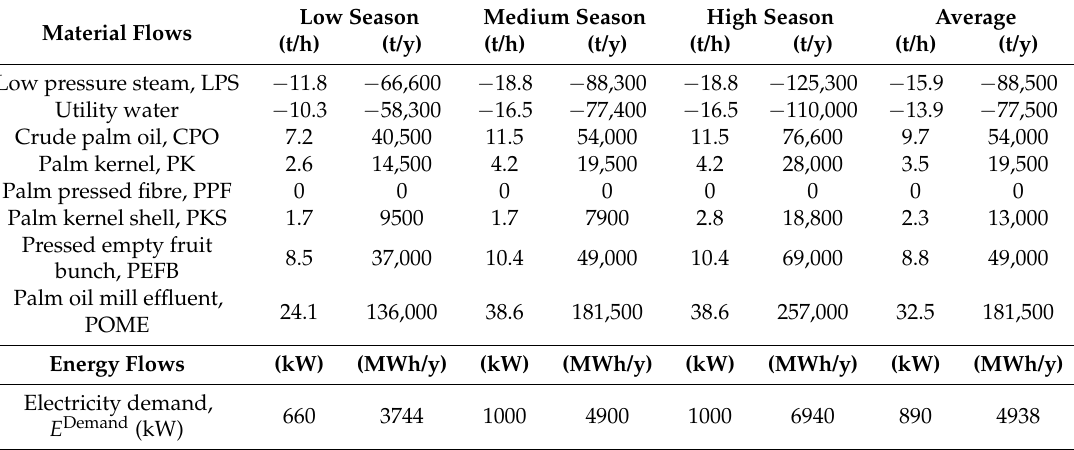
Table 10. Material and energy flows for optimised POM